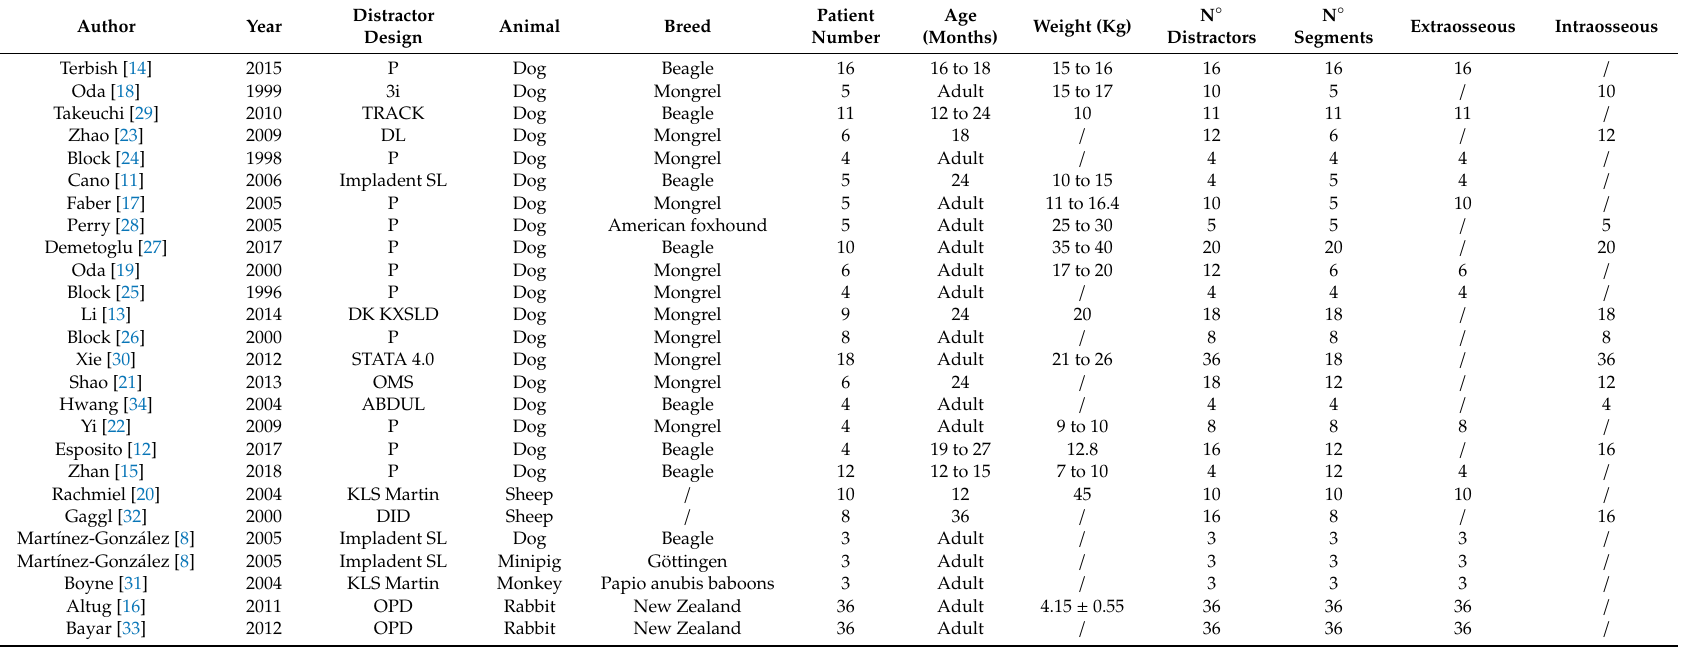
Table 2. Individual parameters of each study (P = prototype)